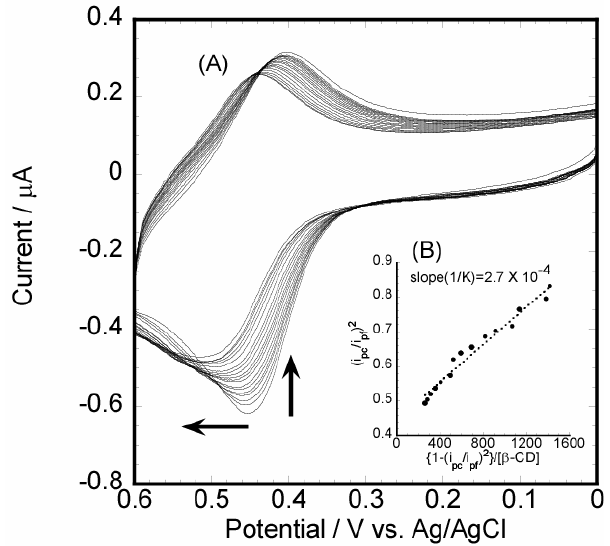
Figure 2. (A) Cyclic voltammograms of a 6-mercaptohexanol-masked gold electrode in 0.1 M AcOK-AcOH buffer (pH 5.6) containing 0.1 M KCl and 0.05 mM 1 in the presence of 0-0.2 mM β -CD and (B) plot of (i CD]. The slope of this plot refers to